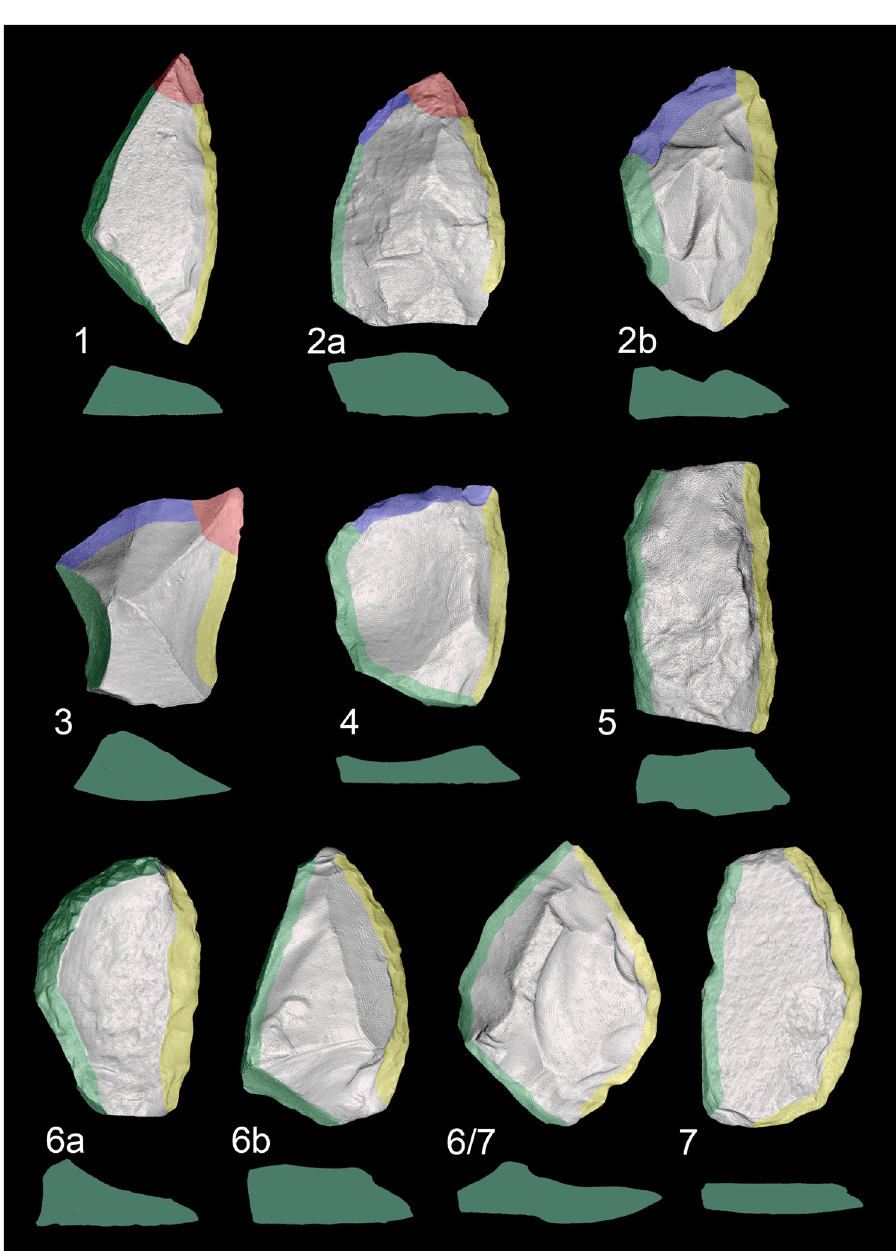
Fig 8. Techno-functional schemes evidenced on samples’ 3D scans. The point is marked in red, the main cutting edge in yellow, the distal cutting edge or bow in blue, the back in green.